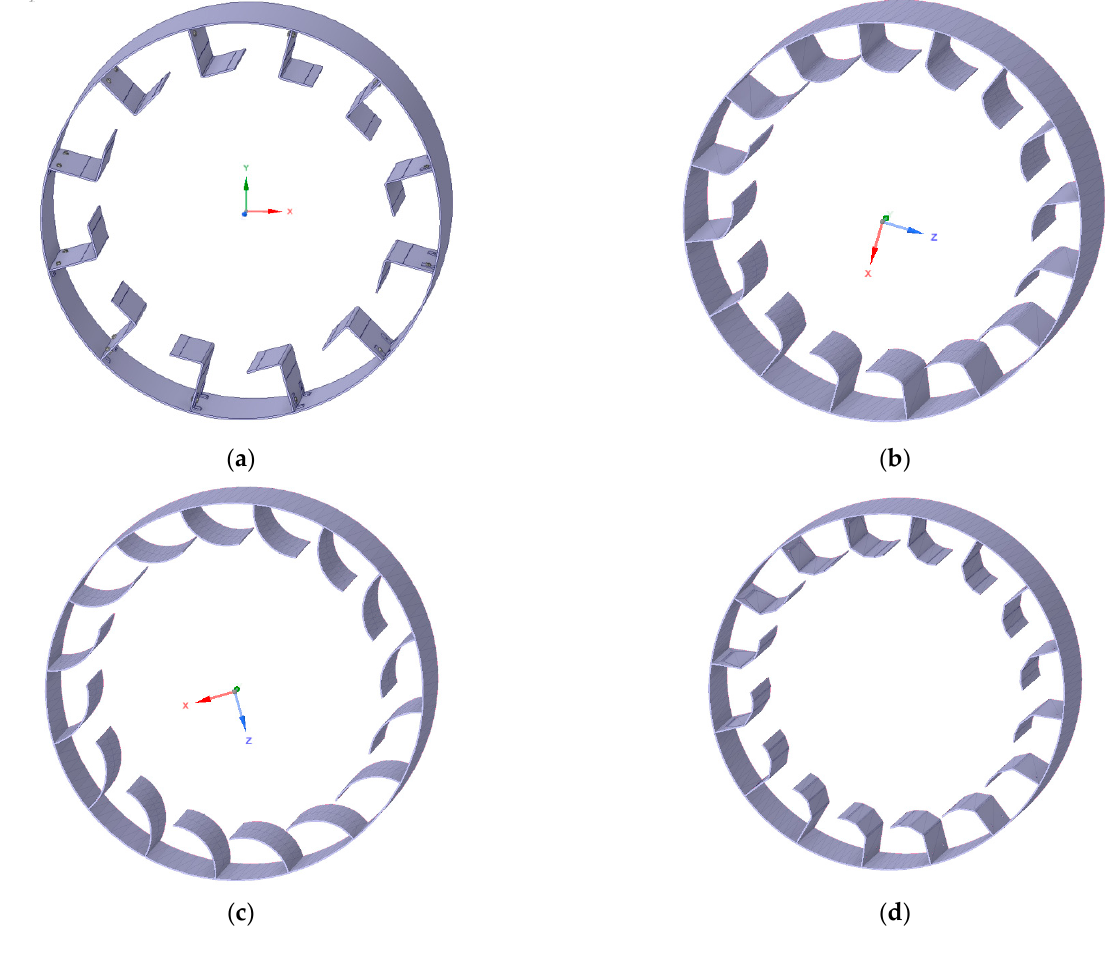
Figure 2. The geometrical models proposed for the analysis: ( a ) L-type flights, ( b ) hook-type flights, ( c ) cup-type flights, ( d ) rectangular double-angled type flights—the real case.